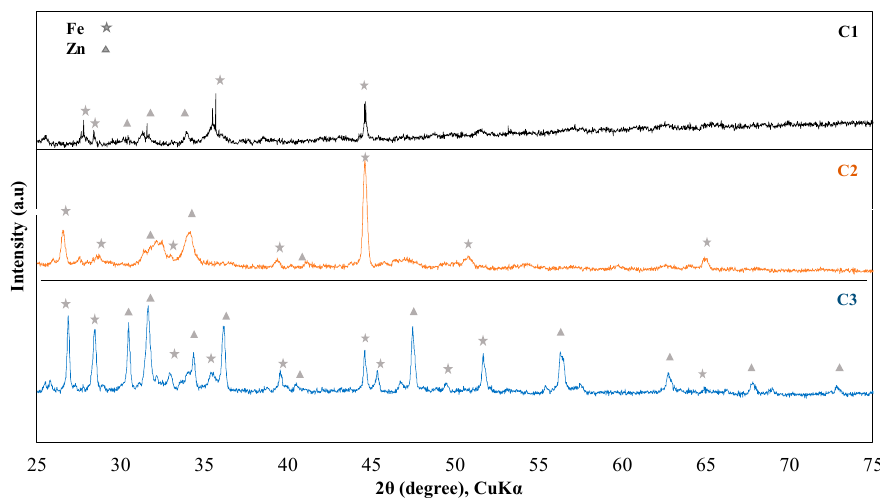
Figure 4. XRD patterns of reduced catalysts C1, C2 and C3.